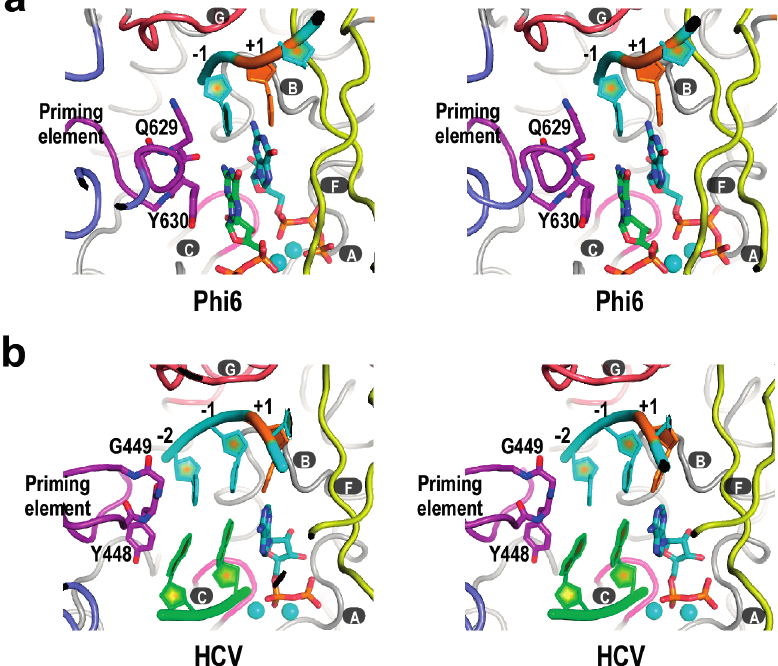
Figure 3. The crystal structures of de novo RdRP initiation complex (IC ) . ( a ) Bacteriophage ϕ 6 polymerase IC structure (pdb entry: 1HI0). Template RNA is in cyan. Initiation NTPs and residues Q629 and Y630 are shown as sticks, and magnesium ions are shown as cyan spheres; ( b ) HCV NS5B IC structure (pdb entry: 4WTJ). Template RNA is in cyan and dinucleotide primer is in green. ADP and residues Y448 and G449 are shown as sticks,